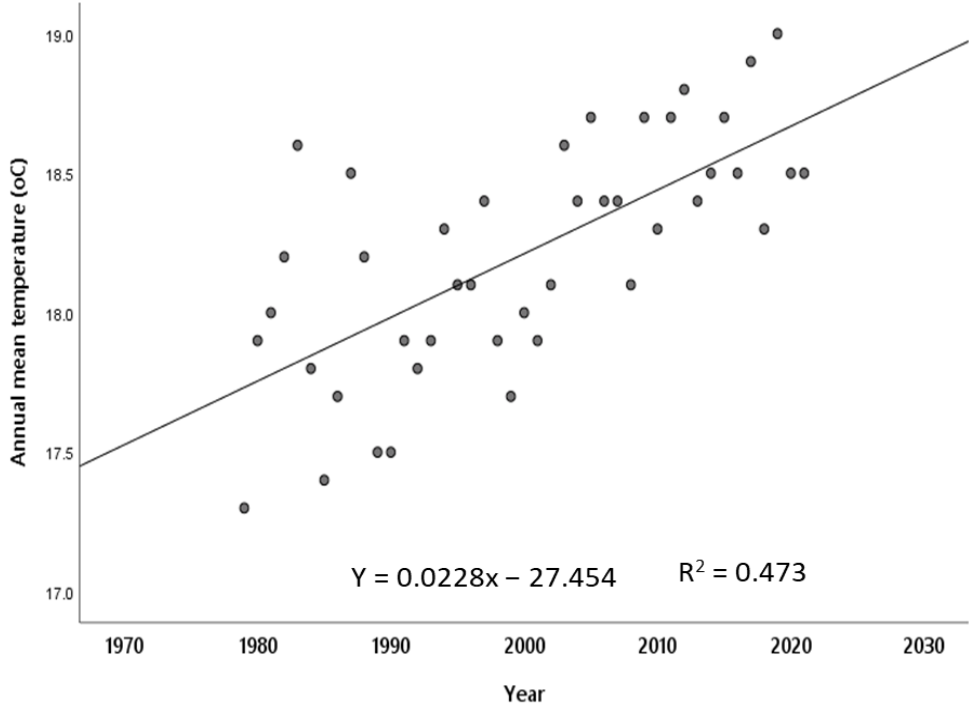
Figure 8. Annual mean temperature changes for Mount Meru, from 1979 to 2021. Linear regression with response variable (Y) and coefficient of determination (R 2 ). with response variable (Y) and coefficient of determination (R 2